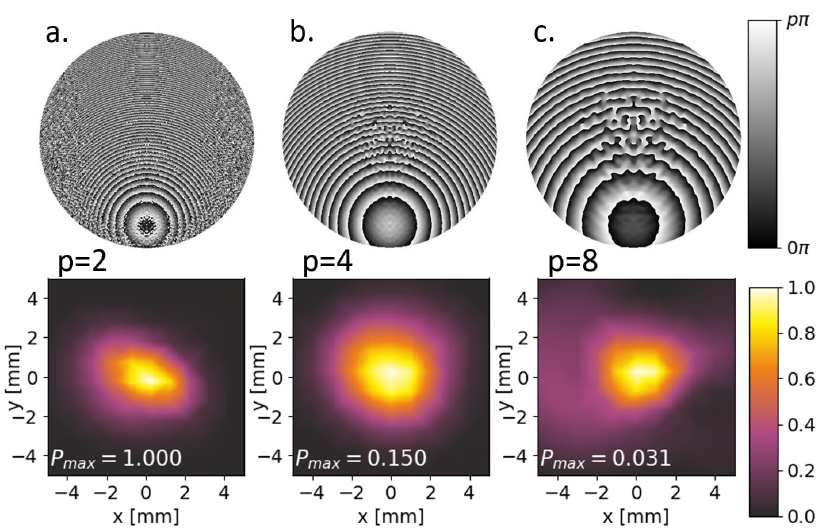
Figure 5. The comparison of phase delay maps ( top panels) of ( a ). 1st ( p = 2 ) , ( b ). 2nd ( p = 4 ) and ( c ). 4th ( p = 8 ) order kinoforms with normalized intensity distributions in focal planes ( bottom panels). All intensity images are normalized to unity, while the maximum power detected for each structure in respect to the value registered for the first order kinoform ( a ) is denoted as P max